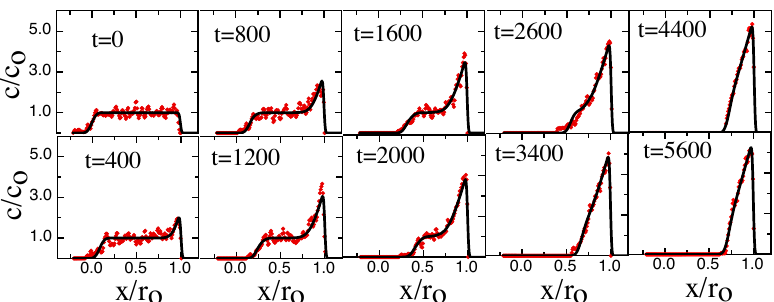
Figure 4. Time evolution of the normalized chain density c ( x , t ) / c 0 along the channel axis for various times during compression with a sliding gasket moving at speed V push = 0.05. The channel width D = 16 and the persistence length L p = 2.5. Time-values are shown in snapshot units, with one snapshot corresponding to 1000 iterations. The red circles correspond to the BD simulation data; the black solid lines correspond to the fitted prediction from the NPDE model. The NPDE model is solved with a D o = 0.74 (bond unit squared per snapshot, obtained from the ramp-slope in steady-state); this D o value leads to a τ = 75,000 (snap-shot units). The best-fit β = 0.07. The σ values were determined from a fit of a uniform concentration profile model to the profile at t = 0. For the edge near the gasket, σ = 0.008 r o . For the edge opposite the gasket, σ = 0.05 r o .